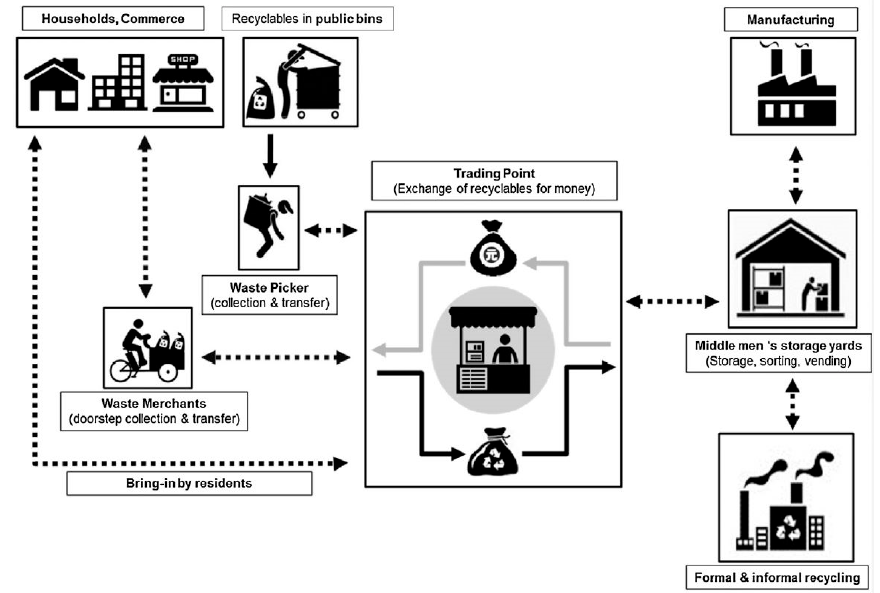
Figure 6. Informal recycling chain in China, as schematically depicted by [128].